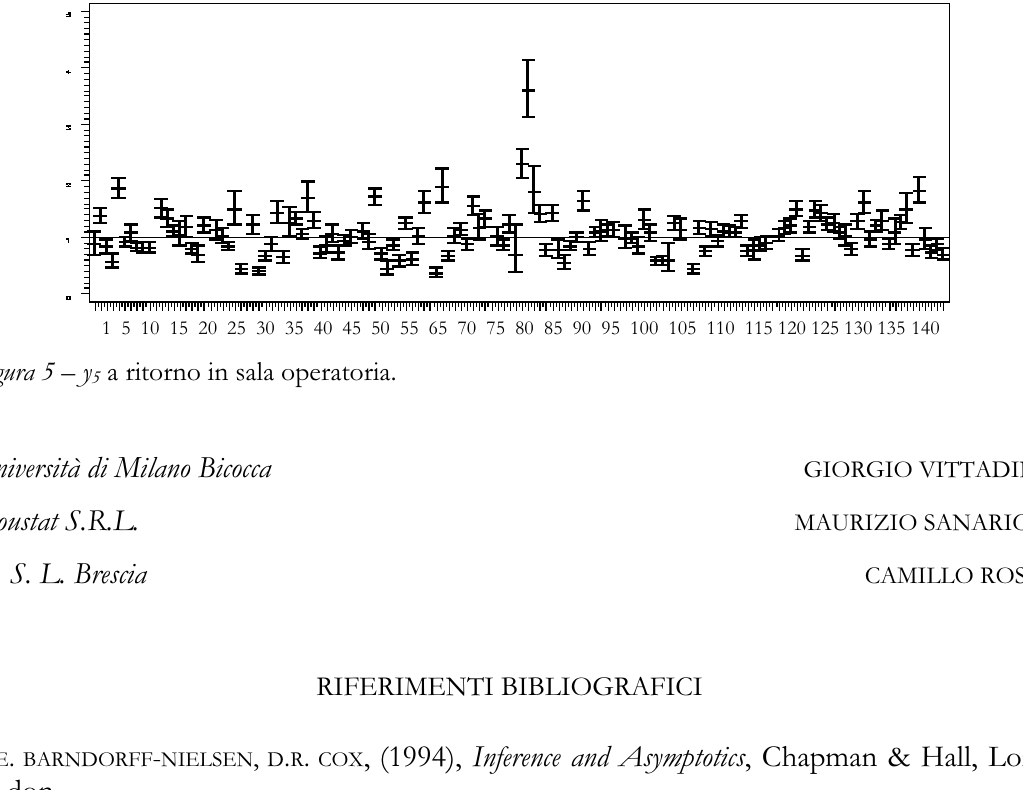
Figura 4 – y 4 ricoveri ripetuti per lo stesso MDC.